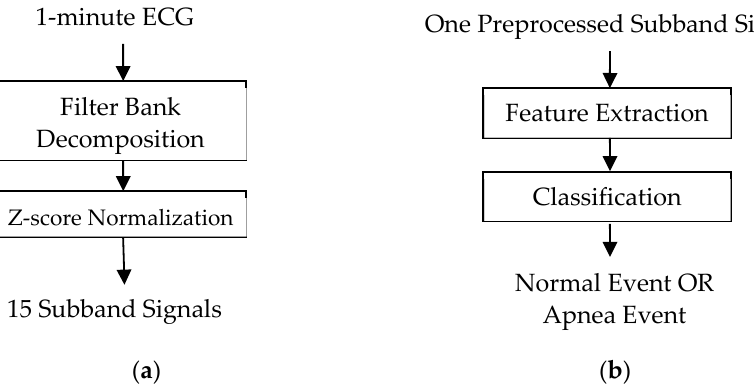
Figure 1. Block diagrams of the proposed sleep apnea detection system including ( a ) the signal pre-processing and ( b ) the 1D CNN model.